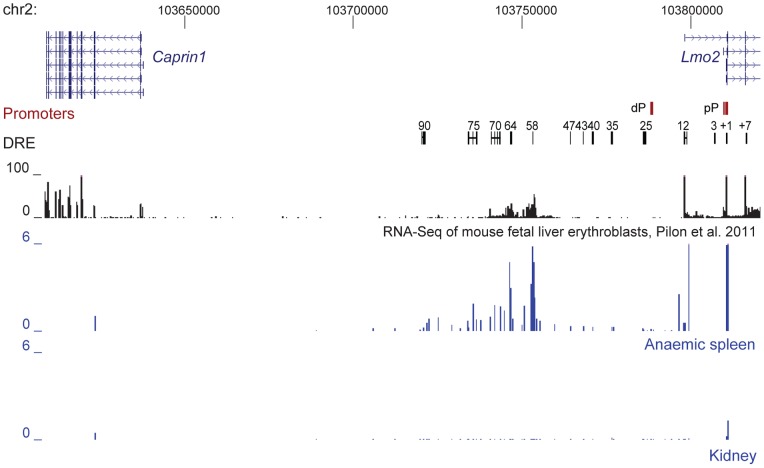
Intergenic transcription occurs upstream of Lmo2 in erythroid cells.The mouse Lmo2-Caprin1 region on chromosome 2 is depicted with chromosome coordinates shown at the top. RNA-Seq data for mouse fetal liver erythroblasts from Pilon et al. 2011 was obtained from the PSU Genome Browser (replicate 1 is shown in black). Transcript levels in adult mouse anaemic spleen and kidney were quantitatively assessed by RT-qPCR (shown in blue) and depicted relative to Gapdh. The levels downstream of 12 DRE (21.57) and the Lmo2 pP (15.07) relative to Gapdh are off scale. Distal regulatory elements (DRE), distal promoter (dP), proximal promoter (pP).